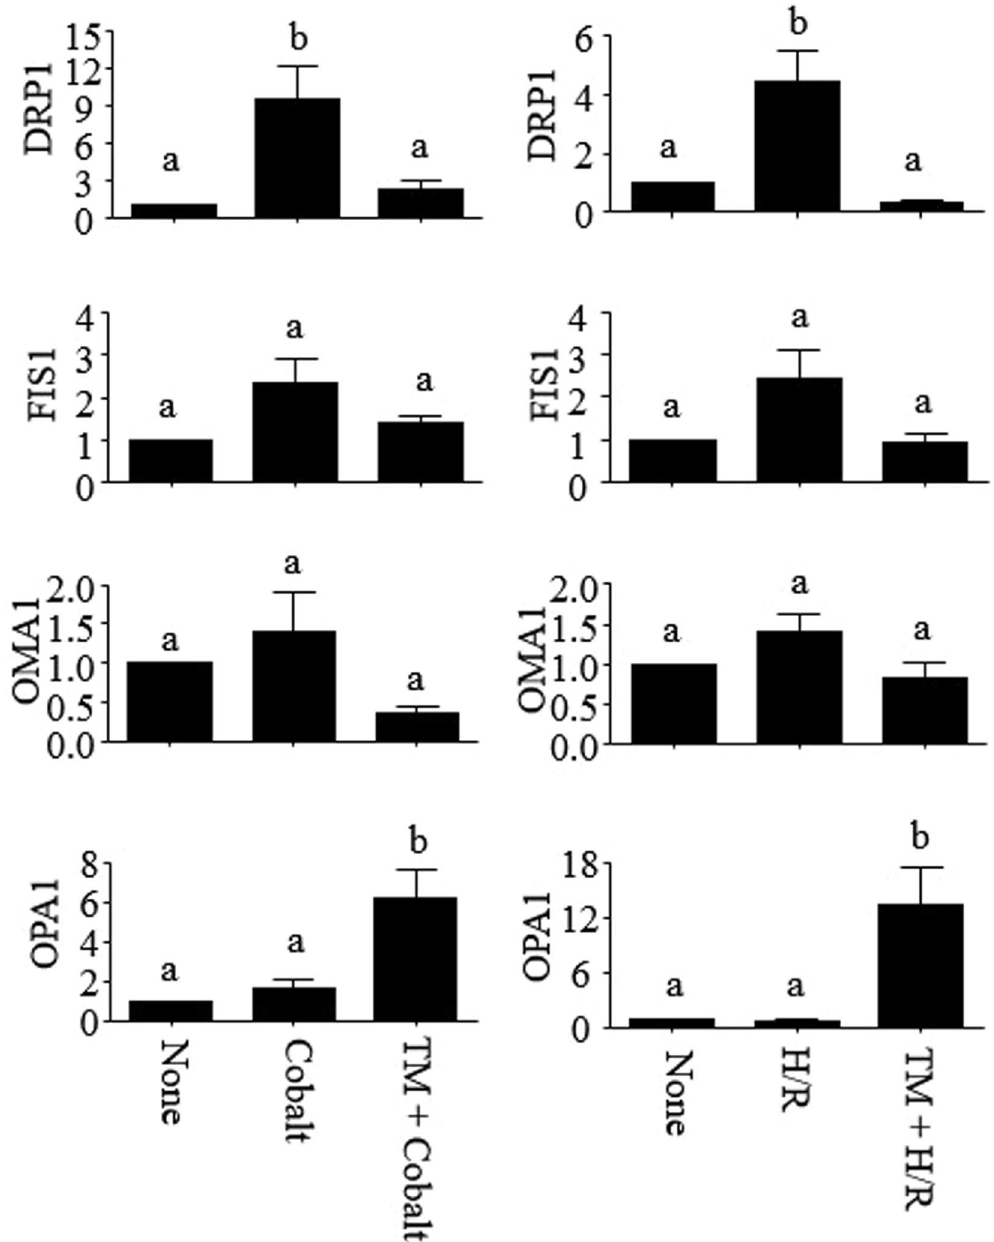
Figure 4. HDAC8 regulates expression of genes involved in mitochondrial fission and fusion. HK-2 cells were exposed to Cobalt (300 µ M; 14–16 h) or incubated in the hypoxia chamber (0.2% O 2 , 5% CO 2 & 95% N 2 at 37 °C) for 24 h, followed by a standard cell culture incubator (~21% O 2 , 5% CO 2 & ~74% N 2 at 37 °C) for the next 5 h (H/R). Expression of DRP1, FIS1, OMA1 and OPA1 mRNAs were analyzed by qPCR. Data are expressed as mean ± S.D. [n = 3; p < 0.05 by one-way ANOVA with Tukey multiple comparison test; columns accompanied by the same letter are not significantly different from each